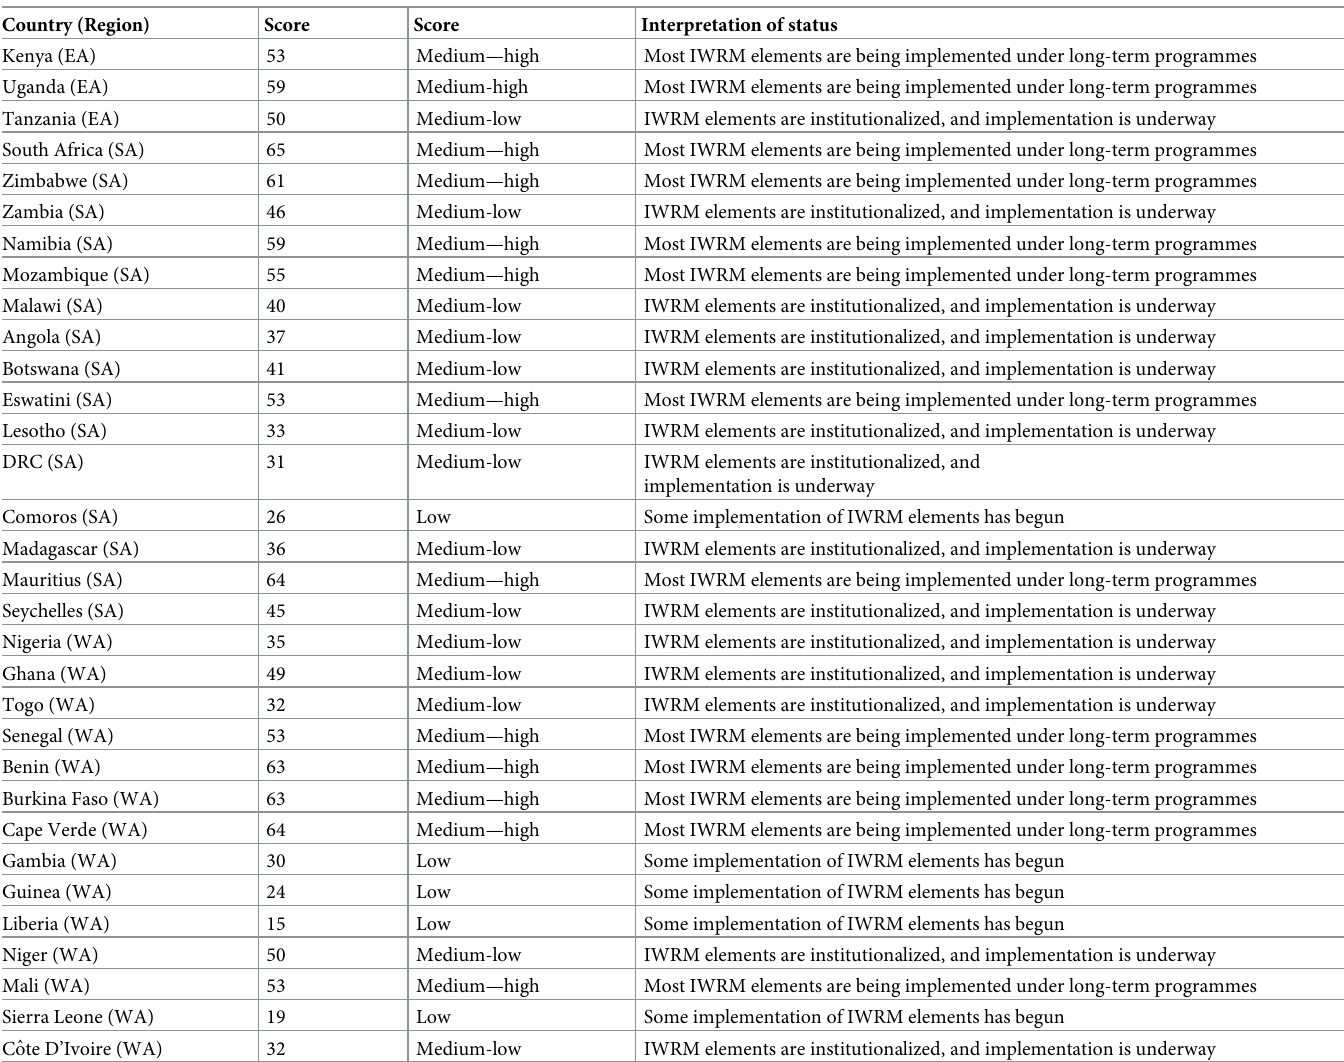
Table 4. Status of IWRM implementation in East, Southern and West Africa regions